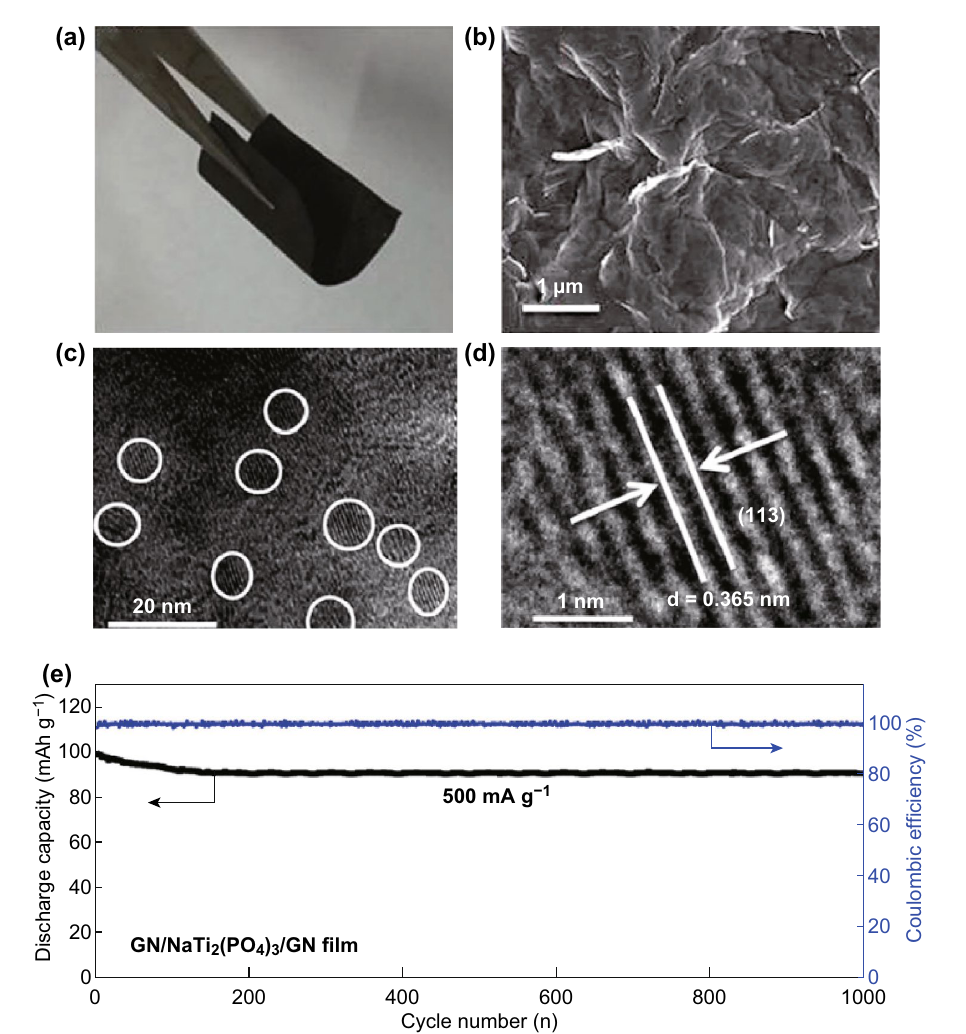
Fig. 8 a Digital photograph and b FESEM images of the as-fabricated flexible GN/NaTi 2 (PO 4 ) 3 /GN film. c, d HRTEM images of GN/ NaTi 2 (PO 4 ) 3 /GN film. e Long-term cycling stability of GN/NaTi 2 (PO 4 ) 3 /GN film electrode at 500 mA g −1 [112]. Copyright 2018, American Chemical